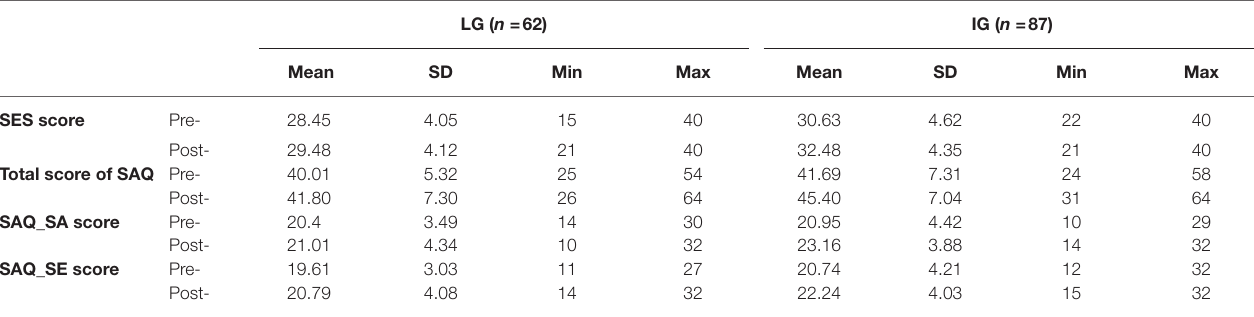
TABLE 4 | The scores in pre-test and post-test for two groups. LG ( n = 62) IG ( n = 87)